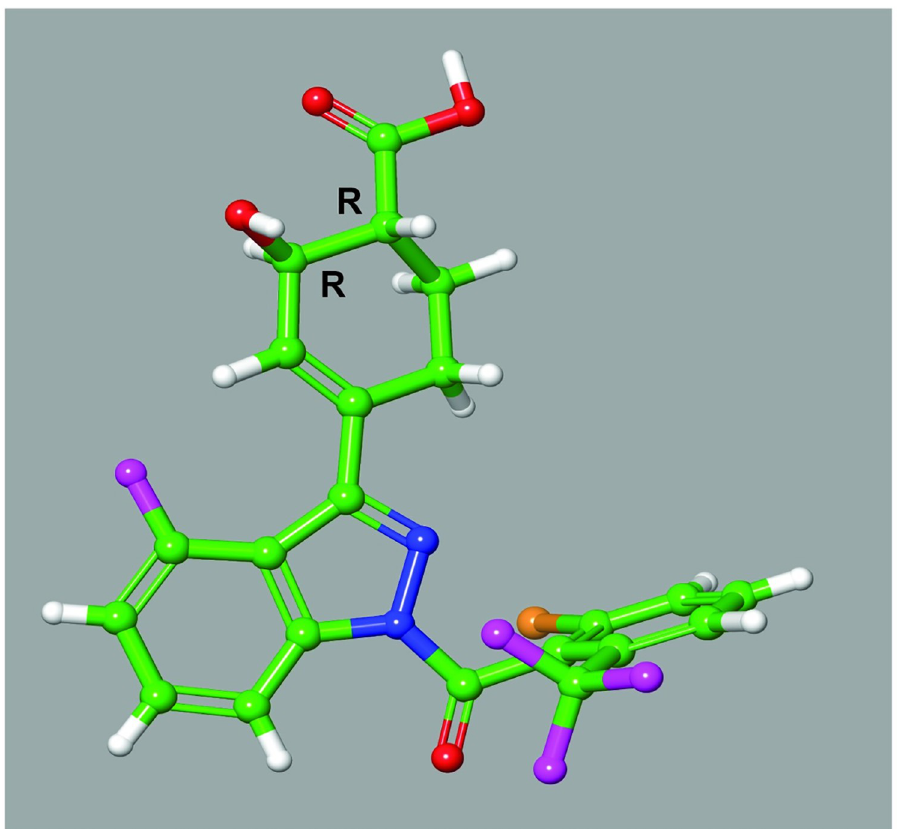
Fig 2. Single molecule X-ray crystallography of Compound 3. Small molecule X-ray structure of Compound 3 indicates only the ( R , R )-enantiomer is present in the crystal structure. Crystal conformation of compound is and depicted in ball and stick representation (carbon–green; hydrogen–white; oxygen–red; nitrogen–blue; fluorine– magenta; chlorine–orange).